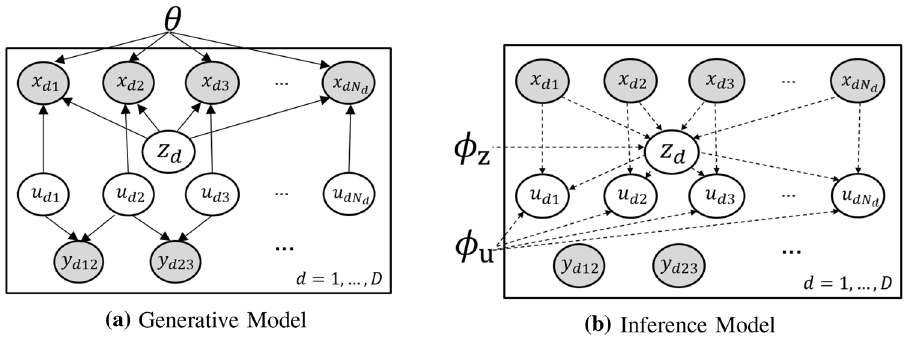
nodes indicate observed and latent variables, respectively. Some pairs 1 of data points in the d -th domain have similar ( y dnm = ) or dissimilar 0 ( y dnm = ) information. The posterior of the domain vector 𝐳 d is esti- N d mated from the set of feature vectors 𝐗 d = { 𝐱 dn } n =